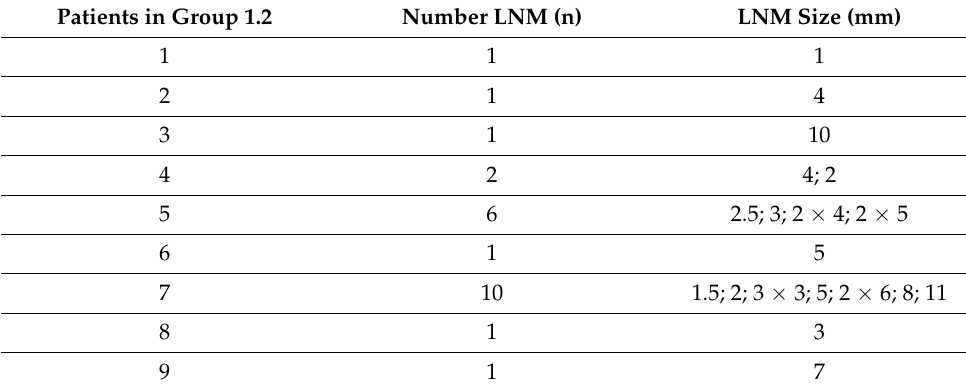
Table 3. Histology in the four groups.